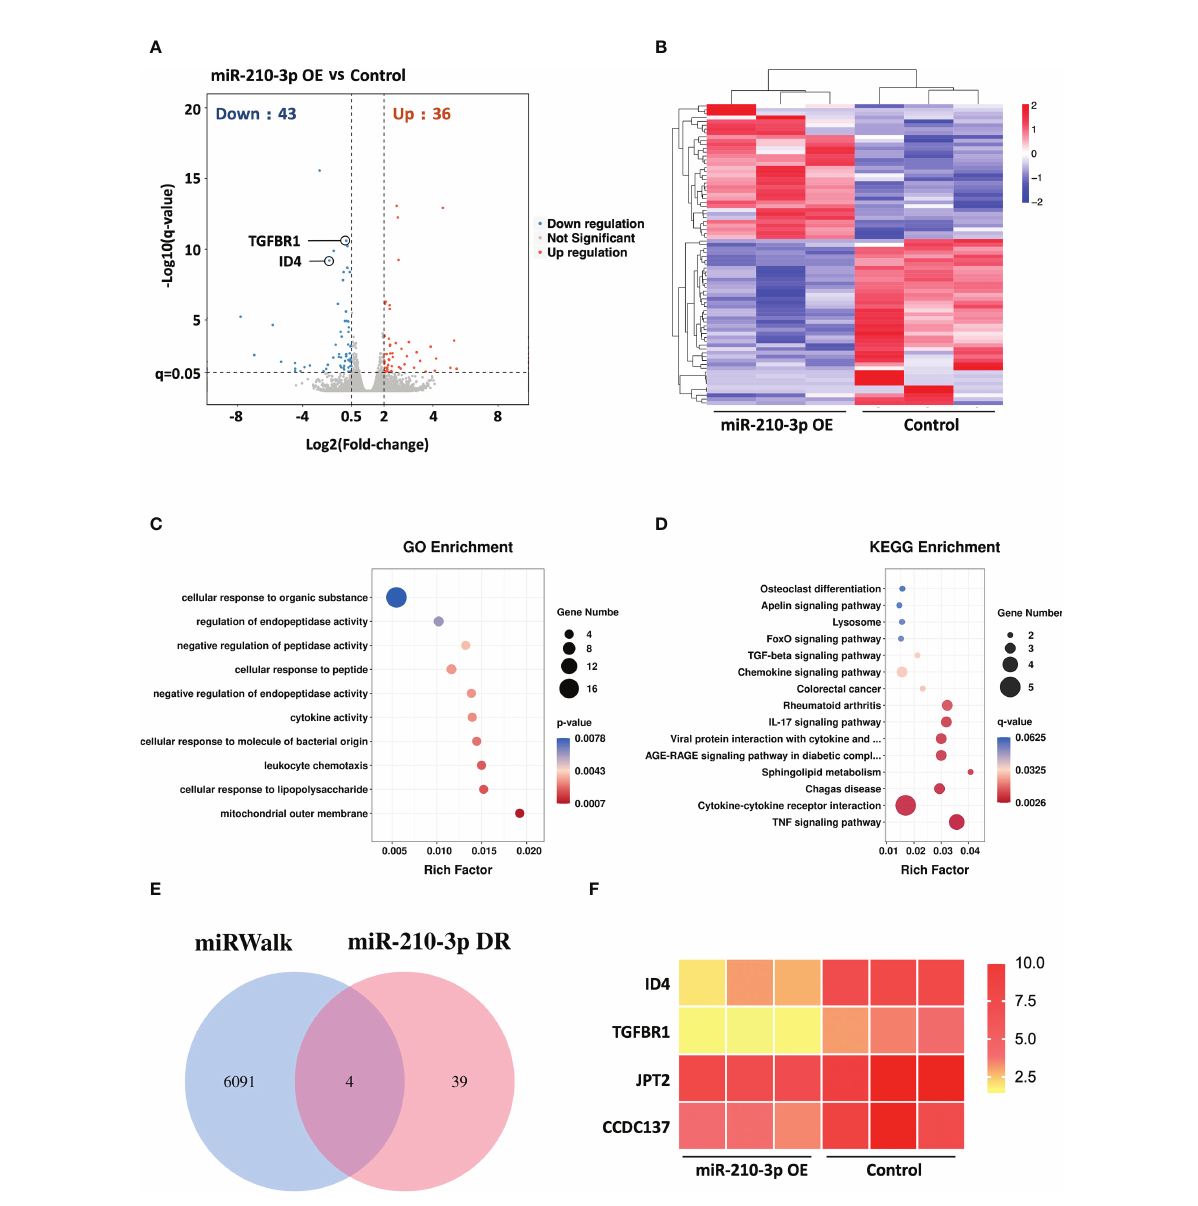
FIGURE 3 RNA sequencing of miR-210-3p-OE HUVECs and miR-210-3p target prediction. RNA sequencing of miR-210-3p-OE HUVECs compared to the control group under hypoxia (n = 3). (A) The differential gene expression analysis showed that miR-210-3p overexpression downregulated 43 genes and upregulated 36 genes (FC > 2, q < 0.05). (B) Heatmap of the differentially expressed genes. (C, D) KEGG and GO enrichment analyses of genes that were differentially expressed in miR-210-3p-OE cells. (E) Venn diagram of miR-210-3p target genes predicted by the miRWalk database intersected with genes downregulated upon miR-210-3p overexpression (FC > 2, q < 0.05). (F) Heatmap of the 4 intersecting